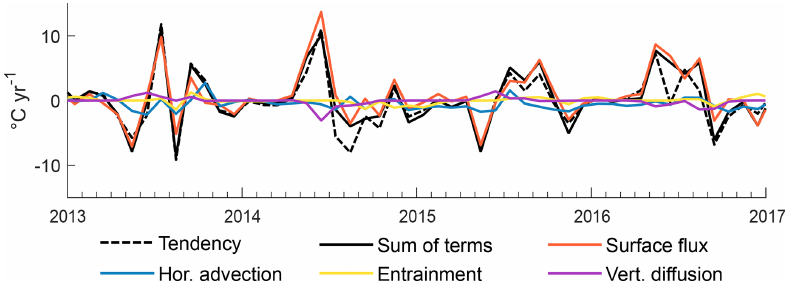
Figure A6. Anomalies in the dominant terms of the mixed-layer temperature budget ( ◦ Cyr − 1 ) relative to the 1992–2015 monthly climatology for ECCOv4-r4, averaged over the northeast of the North Atlantic (53–63 ◦ N, 35–5 ◦ W). Anomalies in the model temperature tendency are shown by the dashed black line and anomalies in the sum of the temperature budget terms driving the change in temperature by the solid black line. The remaining lines represent these individual processes: the surface heat flux (orange), horizontal advection (blue), vertical entrainment (yellow), and vertical diffusion